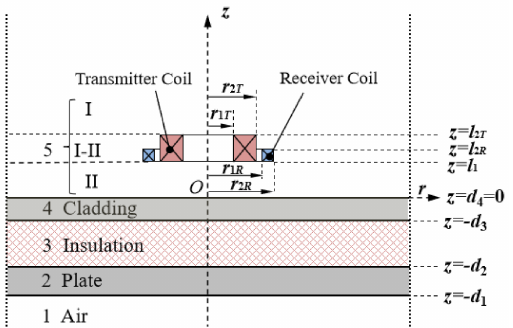
Figure 1. Schematic of a sensor over a four-layered